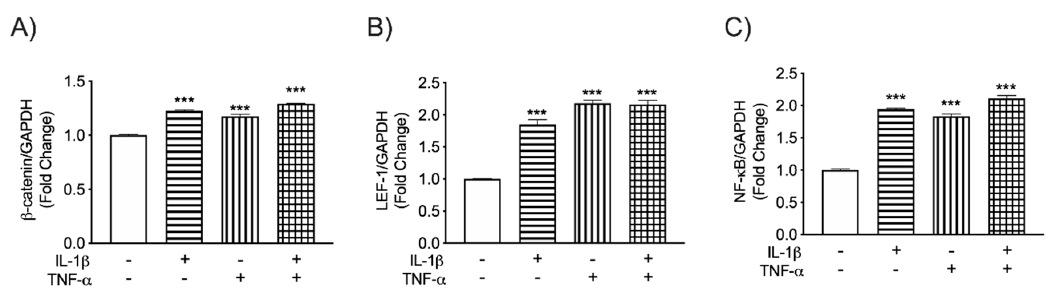
Figure 1. β -catenin, LEF-1 and NF- κ B mRNA levels in IL-1 β and TNF- α treated human astrocytes. Astrocytes were treated with the HIV-associated cytokines interleukin (IL)-1 β (20 ng / mL, horizontal line pattern) and tumor necrosis factor (TNF)- α (50 ng / mL, vertical line pattern) alone or in combination (graph check pattern). Total RNA was isolated 8 h post-treatment. ( A ) β -catenin, ( B ) lymphoid enhancer-binding factor (LEF)-1 and ( C ) nuclear factor (NF)- κ B mRNA levels were determined by real-time (RT-PCR). Data display mRNA fold changes compared to untreated controls. Glyceraldehyde 3-phosphate dehydrogenase (GAPDH) was used as a normalizing control. Data cumulative data from three individual astrocyte donors. Statistical analyses were performed using one-way ANOVA with Tukey’s post-hoc test for multiple comparisons (*** p < 0.001, compared to an untreated control).